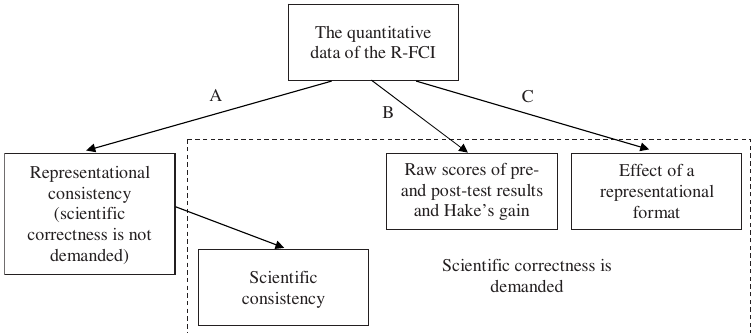
FIG. 3. Different ways for analyzing the R-FCI